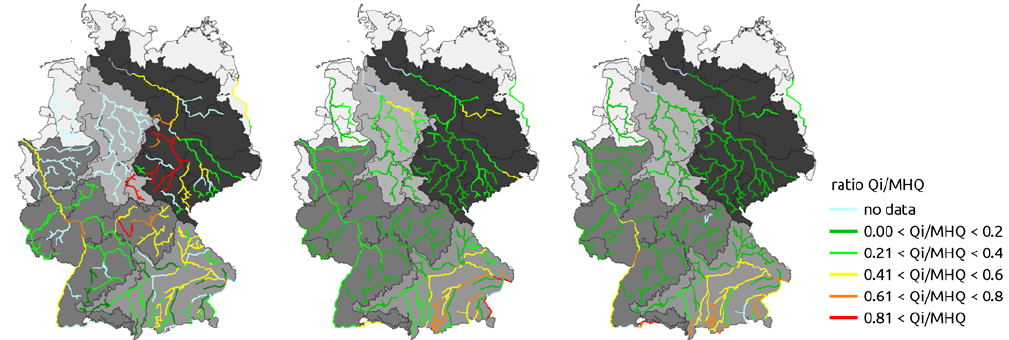
Figure 9. Initial flow ratio at meteorological event start Q i normalized for MHQ (calculated from AMS 1950–2009) for June 2013 (left), August 2002 (middle) and July 1954